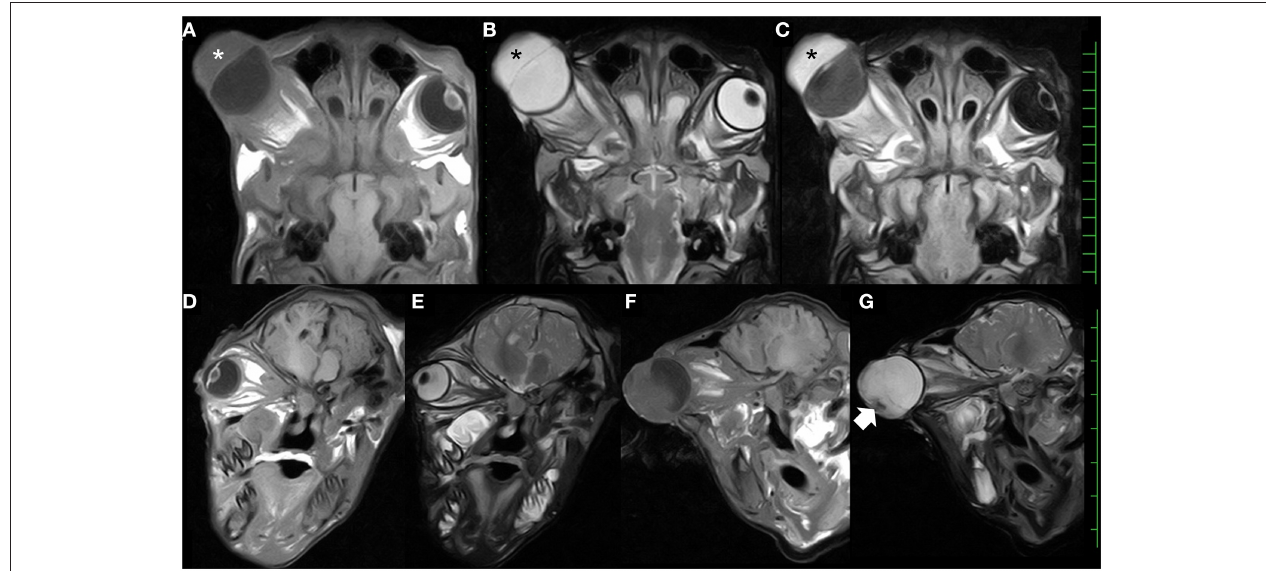
FIGURE 3 | Dorsal T1-weighted (A) , T2-weighted (B) , and fluid-attenuated inversion recovery (C) magnetic resonance images, showing the presence of the thickened parenchymal lesion (asterisks) located in the anterior region of the enlarged eyeball. Oblique sagittal T1-weighted and T2-weighted magnetic resonance images of the left eye (D,E) and the right eye (F,G) , showing the optic nerves running within the retrobulbar region. The hypointense structure (arrow) is seen in the front and lower side of the hyperintense anterior lesion within the right eye. Scale: